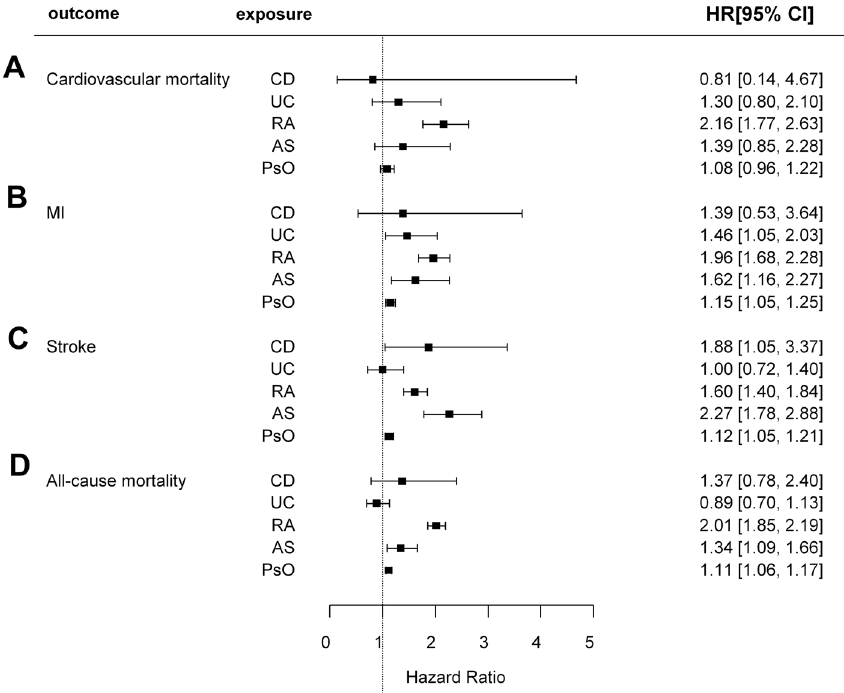
Figure 3. A forest plot showing IPTW-adjusted HRs and 95% CIs for ( A ) cardiovascular mortality, ( B ) MI, ( C ), stroke, and ( D ) all-cause mortality. IPTW, inverse probability of treatment weighting; HR, hazard ratio; CI, confidence interval; CD, Crohn’s disease; UC, ulcerative colitis; RA, rheumatoid arthritis; AS, ankylosing spondylitis; PsO, psoriasis; MI, myocardial